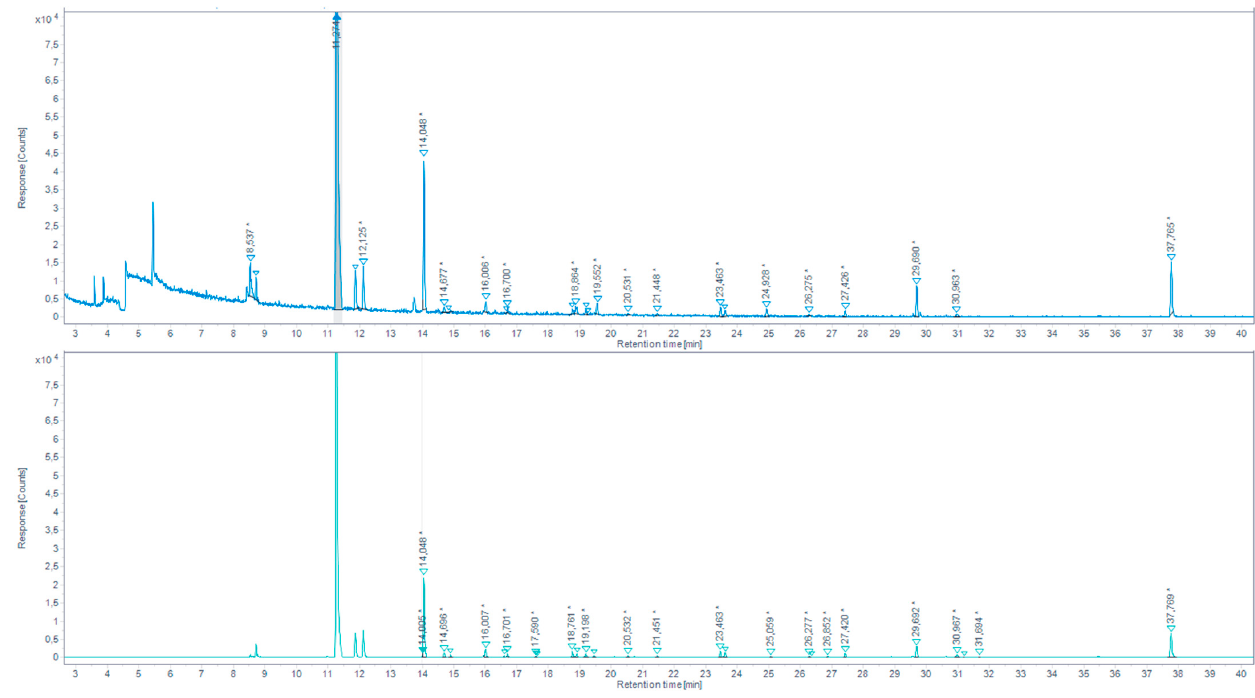
Figure 5. Total ion chromatogram (TIC) for the browned chicken meat juices extracted by SAFE and derivatized with PFBHA (up) and the extracted-ion chromatogram (EIC) 180.7–181.7 m/z (down) (* indicates that the peak has been manually integrated). Table 3. Identification of carbonyl compounds in browned chicken meat juices extracted by SAFE and derivatized with PFBHA based on RT, KRI, and fragmentation.